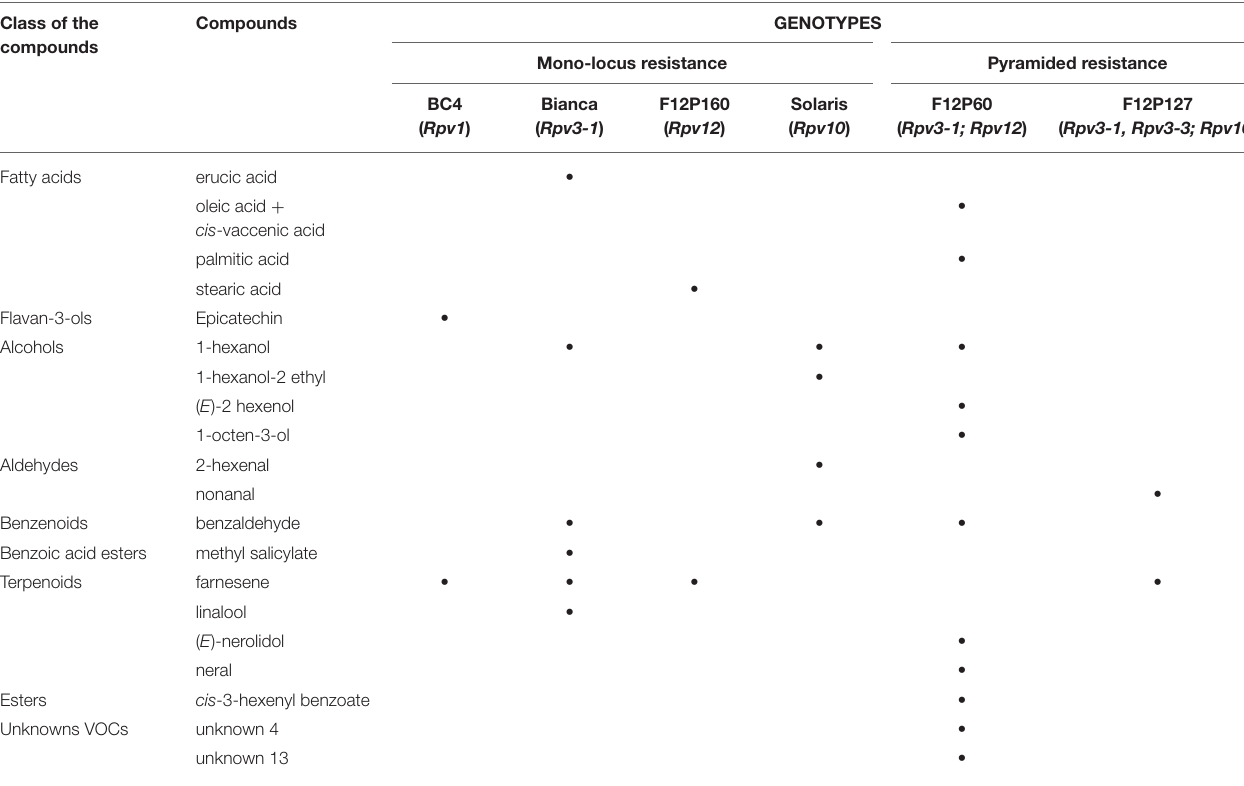
TABLE 2 | Potential biomarkers among all metabolite classes except stilbenes and stilbenoids as identified by the selection criterion—modulation only in the resistant genotypes (d > 1). Class of the